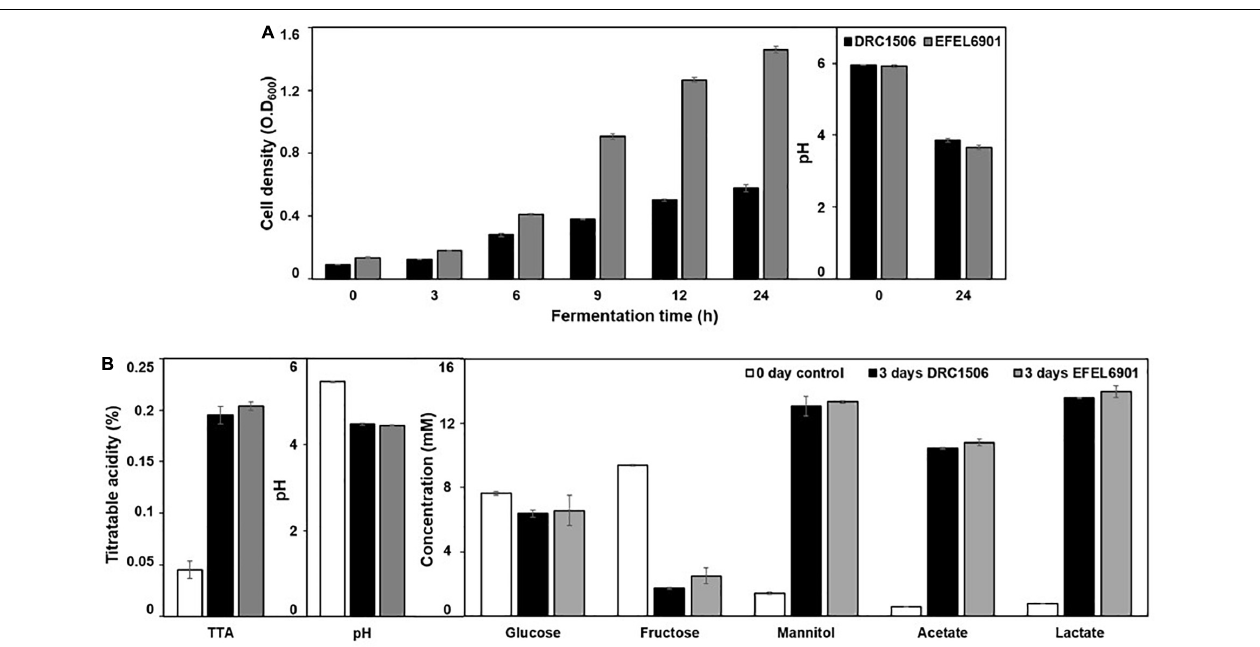
FIGURE 9 | Fermentation profiles of Limosilactobacillus reuteri EFEL6901 in simulated kimchi juice (SKJ) (A) and nabak-kimchi (B) showing changes of cell density, titratable acidity, pH, carbon sources (glucose and fructose), and metabolites (mannitol, acetate, and lactate). (A) L. reuteri EFEL6901 and Leuconostoc mesenteroides DRC1506, a commercial kimchi starter, were cultured in SKJ at 37 ◦ C and 30 ◦ C, respectively. (B) L. reuteri EFEL6901 and Le. mesenteroides DRC1506 were inoculated in nabak-kimchi and incubated at 10 ◦ C for 3